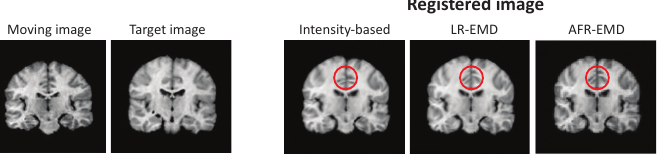
Figure 8. Target and reference images from IBSR MR dataset and registered images using our two methods and intensity-based hierarchical